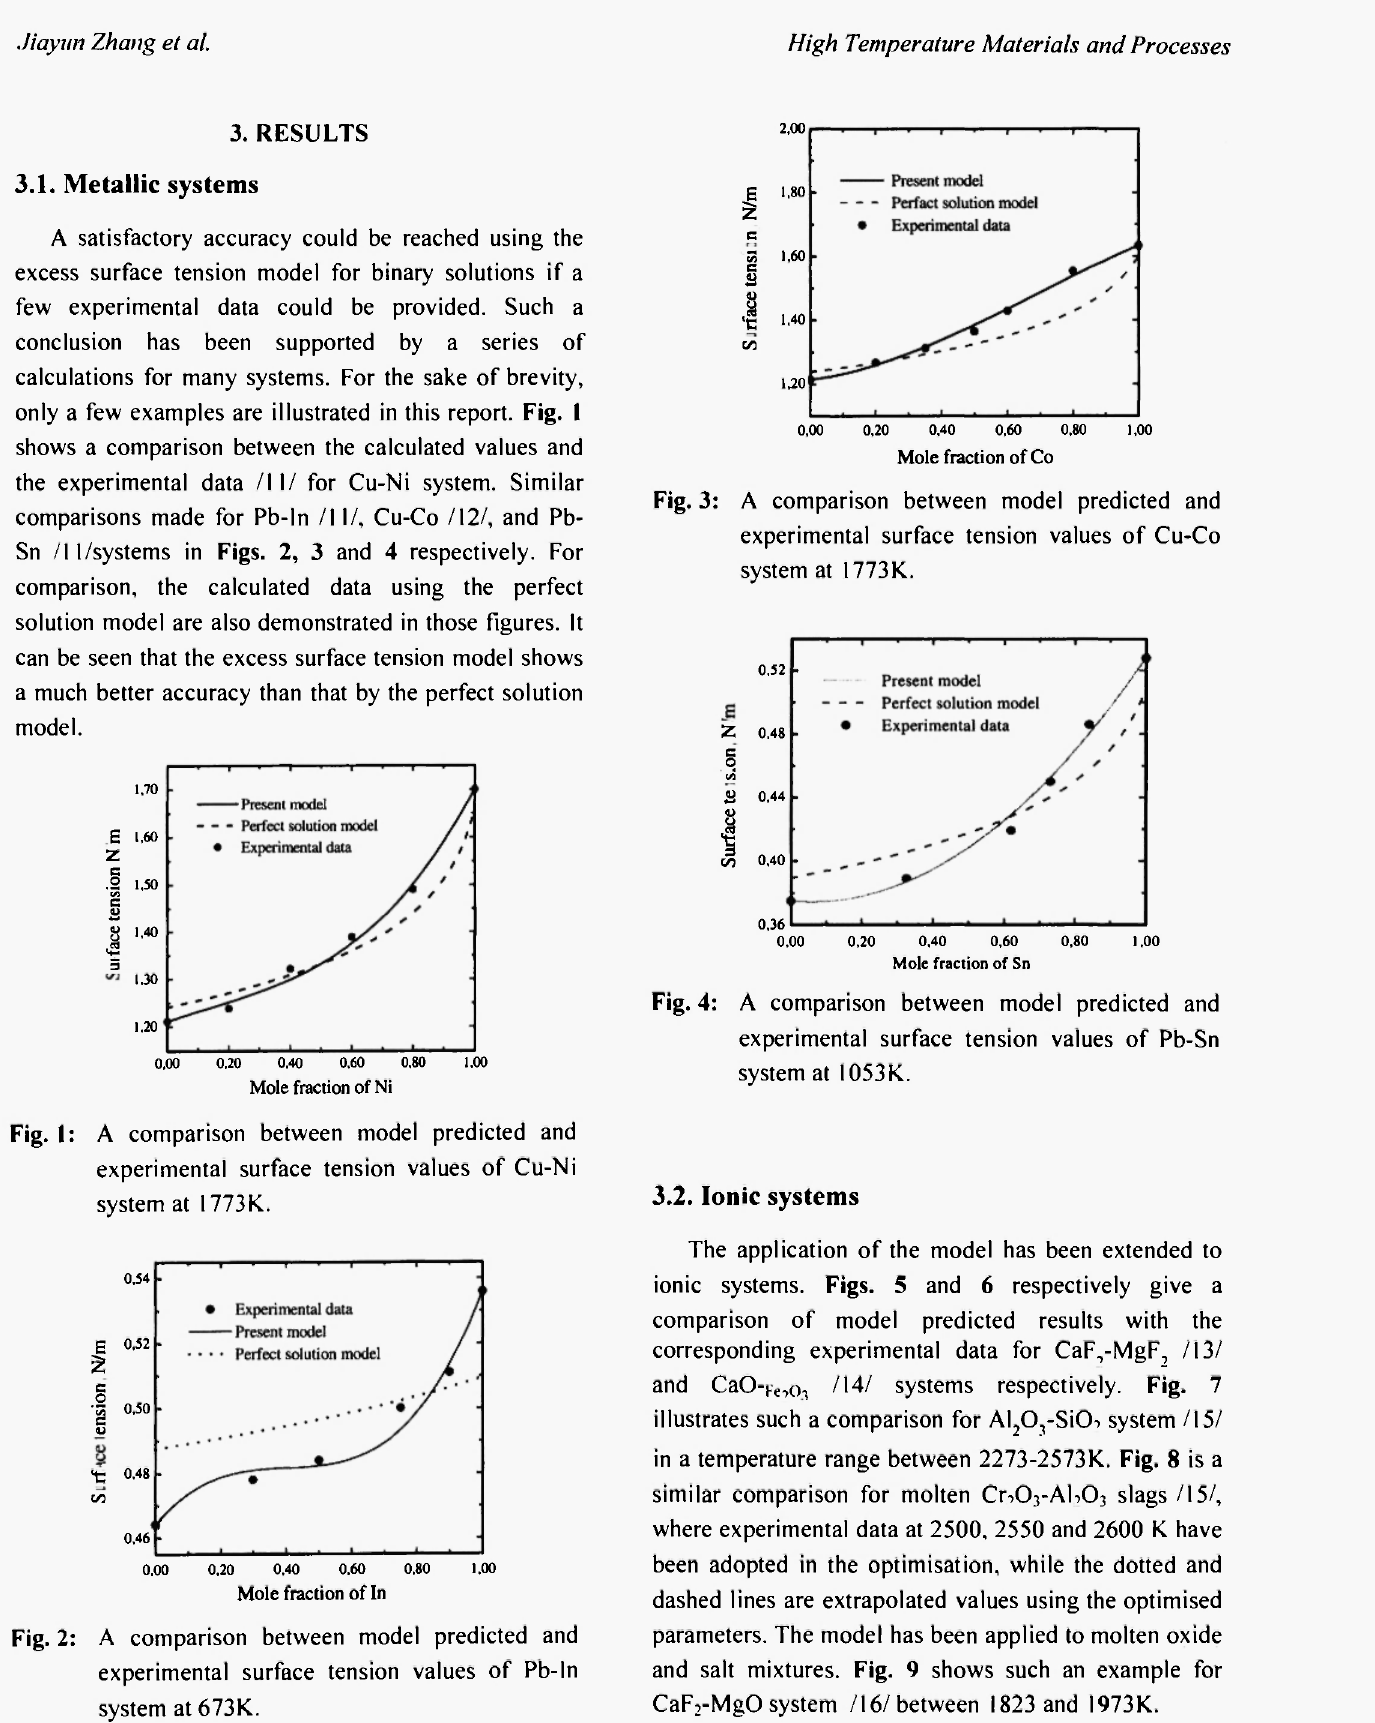
illustrates such a comparison for A l ^ - S i Oi system /15/ similar comparison for molten CriO.rAliOj slags /15/, where experimental data at 2500, 2550 and 2600 Κ have been adopted in the optimisation, while the dotted and dashed lines are extrapolated values using the optimised parameters. The model has been applied to molten oxide and salt mixtures. Fig. 9 shows such an example for CaF 2 -MgO system 716/ between 1823 and